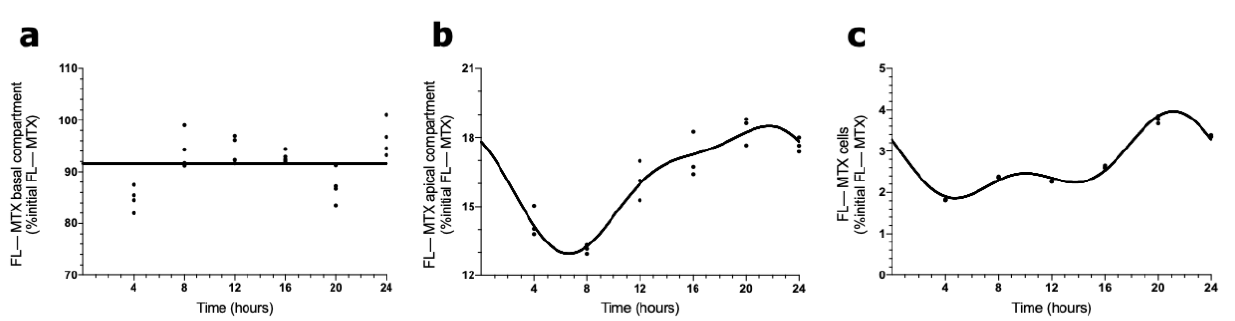
Figure 6. Effects of ABCG2 inhibition in FL–MTX circadian transport across the BCSFB. CircWave analysis of FL–MTX levels from basal ( a ), apical ( b ), and intracellular ( c ) compartments after the inhibition of ABCG2. The represented curves indicate a statistically significant rhythm (CircWave, p < 0.05).